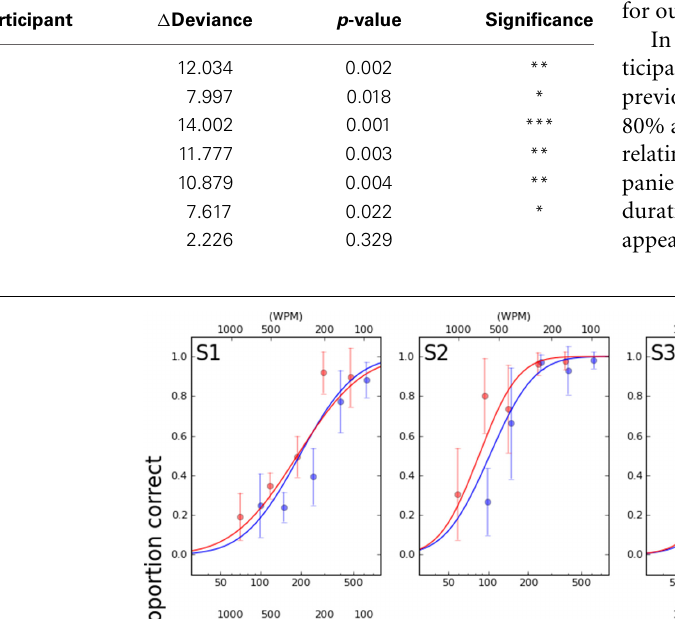
FIGURE 6 | First (blue curve) and last (red curve) psychometric functions for each participant, interpolated from model M var . Abscissa is word duration, shown in milliseconds on the bottom axis and equivalent reading